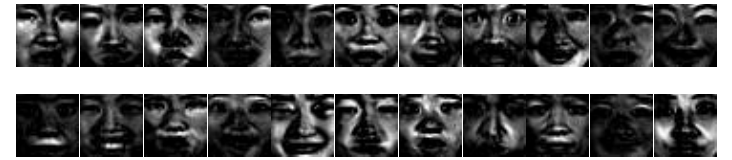
Figure 8. Features achieved by sparse NMF for MUG dataset.